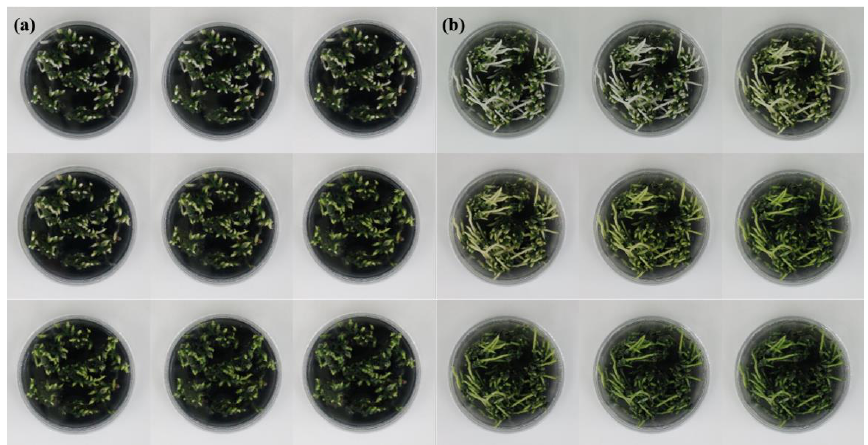
Figure 2. Chlorophyll accumulation after light treatment in rhizomes of Cymbidium hybrids RB003 and RB012. ( a ) RB003; ( b ) RB012. From the upper left: dark-treated rhizomes treated with light for 0, 1, 5, 7, 10, 14, 15, 20, and 21 days. Dark treatment durations were 60 and 75 days for the rhizomes of Cymbidium hybrids RB003 and RB012, respectively.